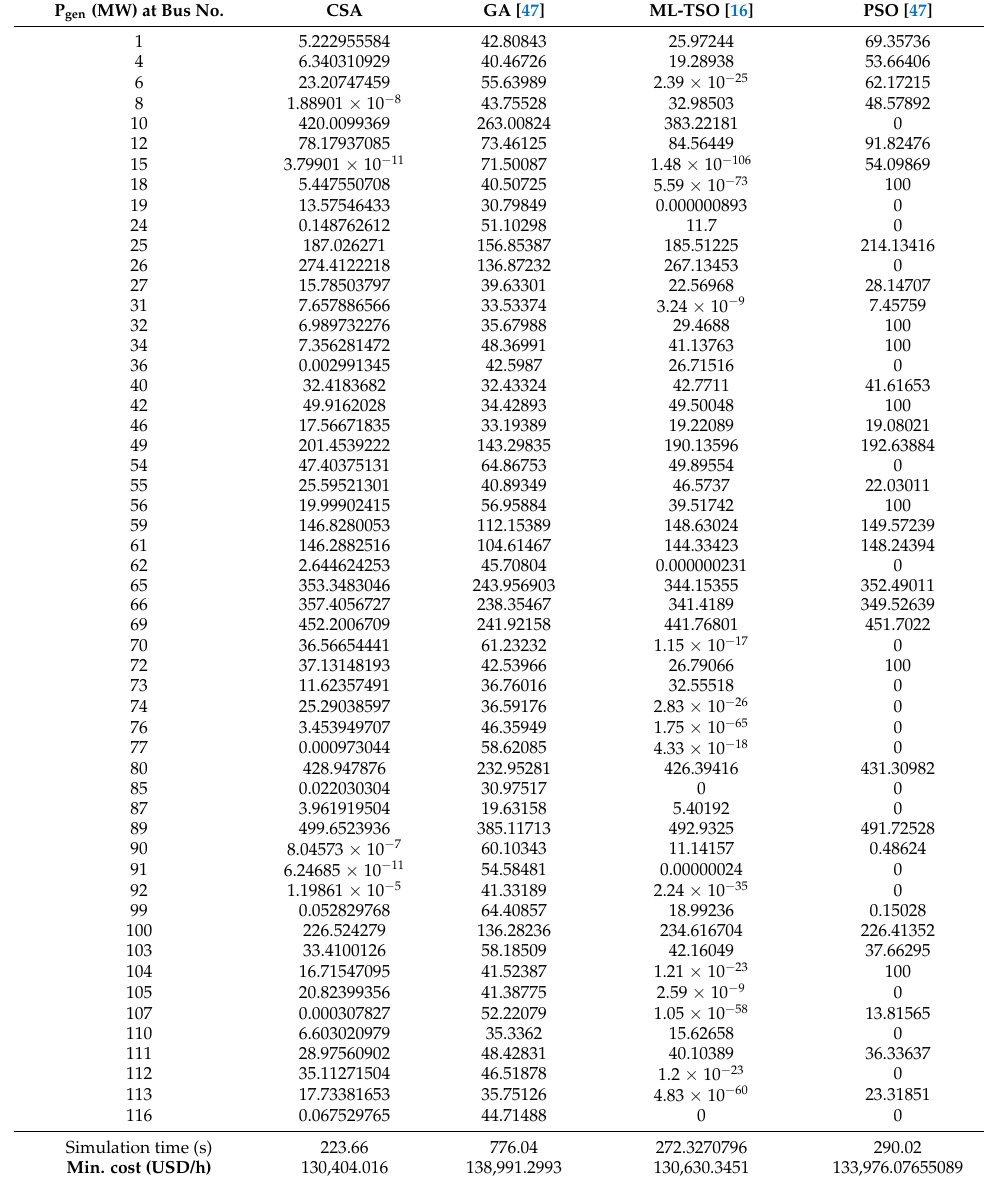
Table 5. Min. objective and optimal design variables in the case of the 118-bus system. P gen (MW) at Bus